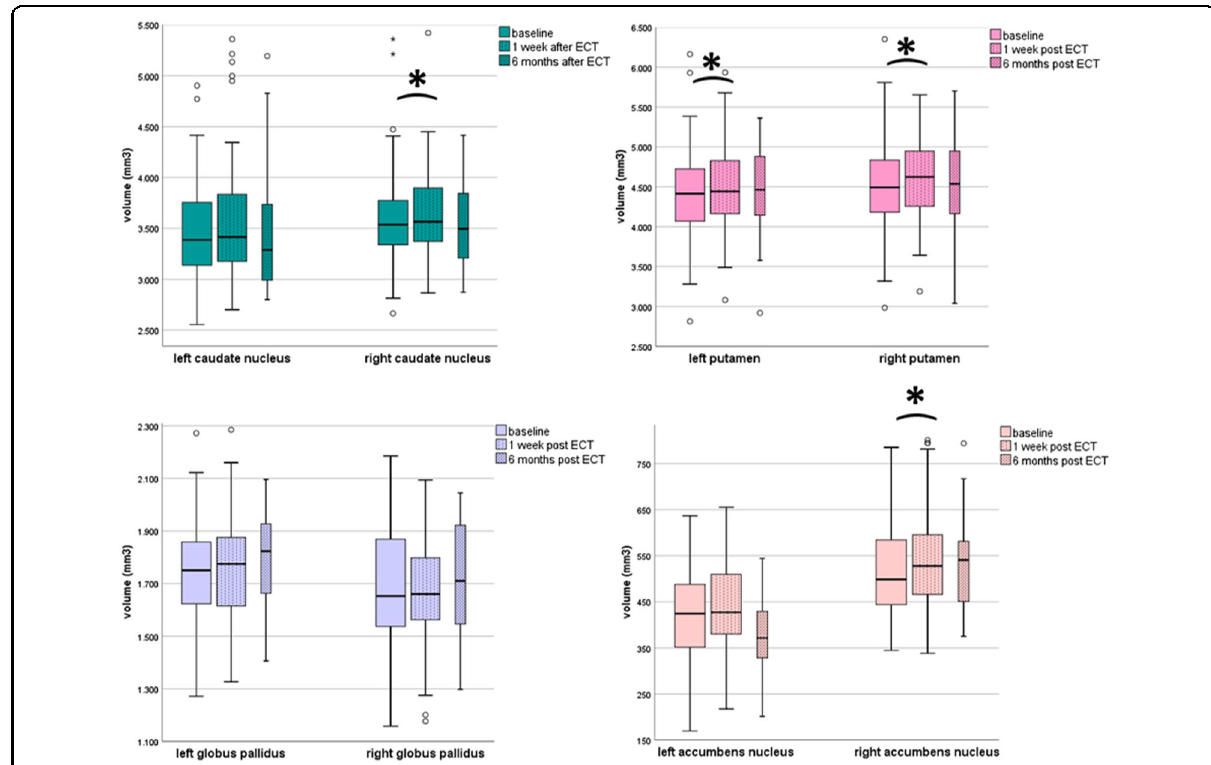
Fig. 4 Basal ganglia volumes before and after ECT. Box-and-Whisker ’ s plot of basal ganglia ROI volume at baseline ( t 0 , n = 66), one week after ( t 1 , n = 66), and six months after ECT completion ( t 2 , n = 22). Student ’ s paired t test for related samples, sign. level α = 0.05 (2-tailed), * p signi fi cance adjusted after Bonferroni – Holm correction for multiple testing. Black squares = outliers (>|2x SD|), diamonds = extreme outliers (>|3x